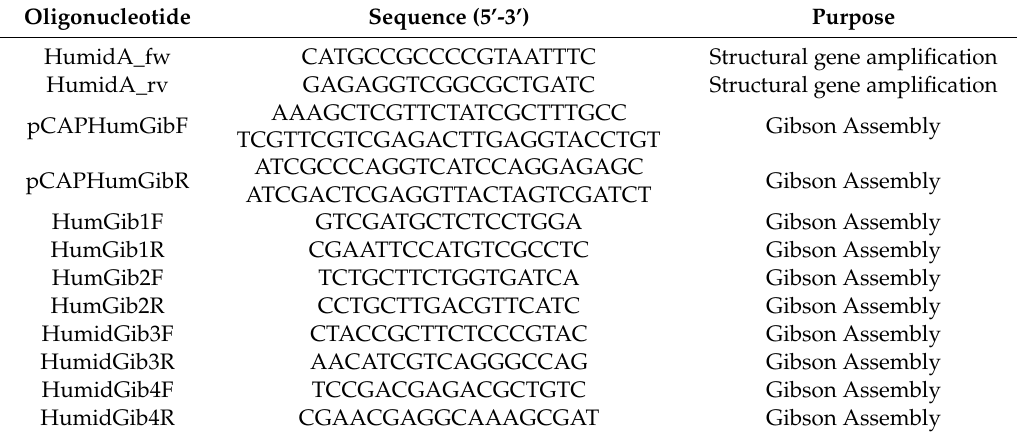
Table 2. Primers used in this